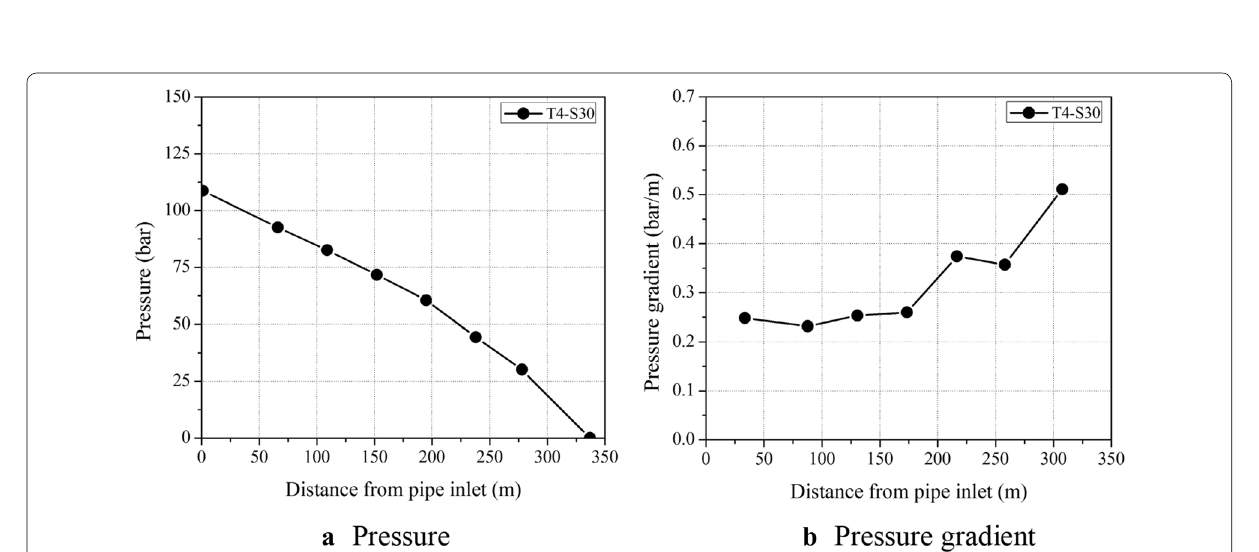
Fig. 10 Results of pressure and pressure gradient over the pipe length—increase